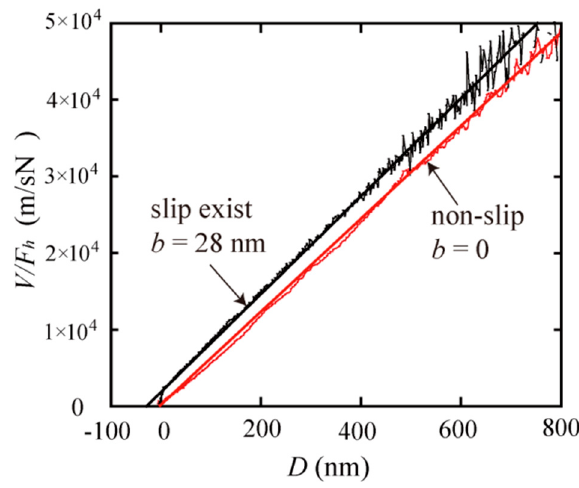
Figure 10. Boundary slip measurements on different surfaces: black, OTS; red, mica.